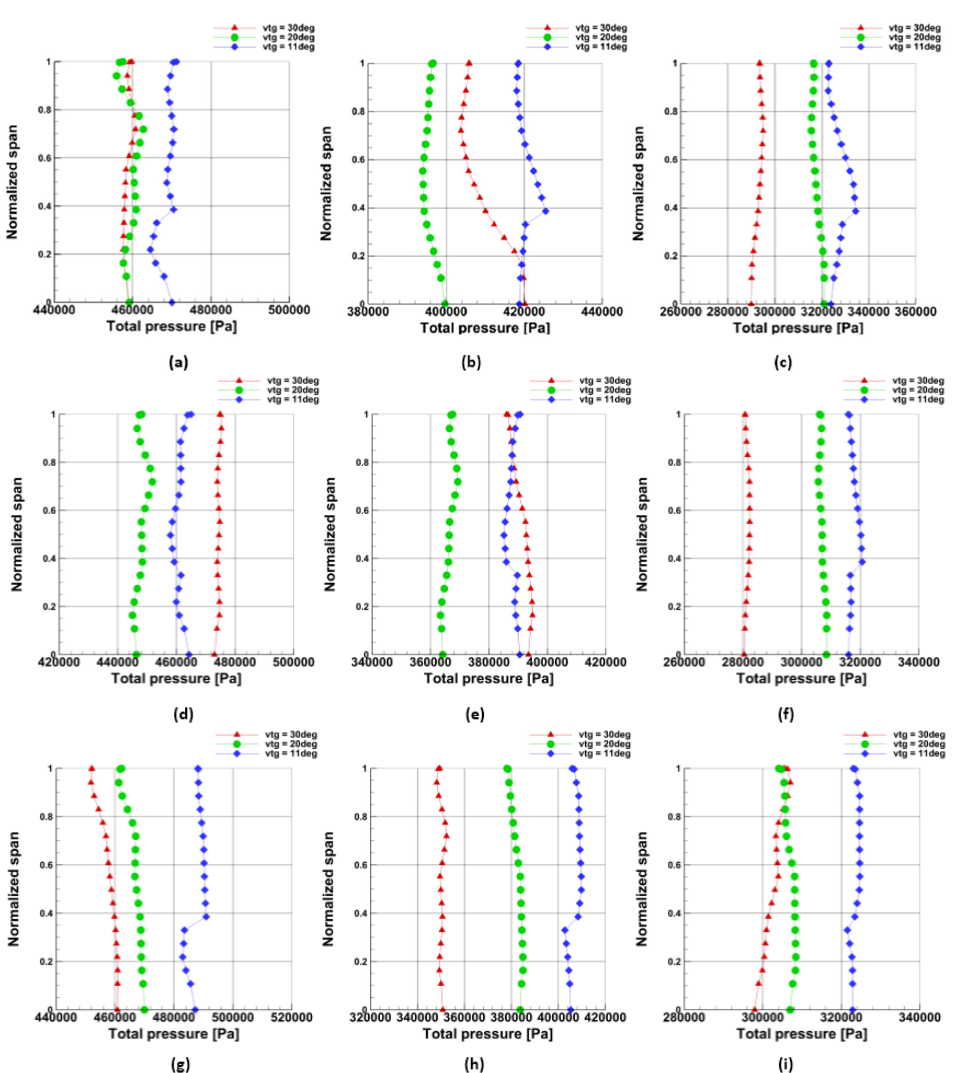
Figure 24. The plots of the total pressure measured behind the 1st stage nozzle vane against the blade height for: ( a – c ) 60,000 rpm point A, B, C respectively, ( d – f ) 50,000 rpm point A, B, C respectively, ( g – i ) 40,000 rpm point A, B, C respectively.